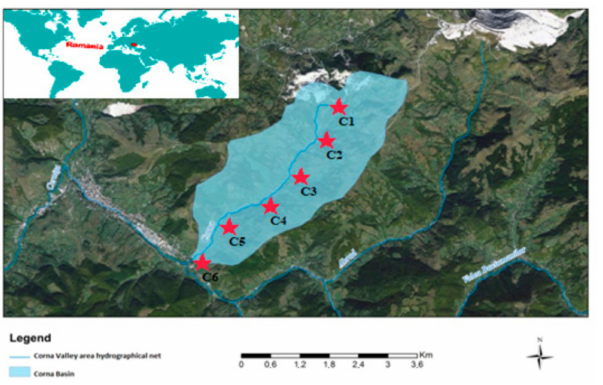
Figure 1. Location, boundaries, and sampling stations (C1 – C6) from upstream to down- stream of the Corna Valley hydrographic